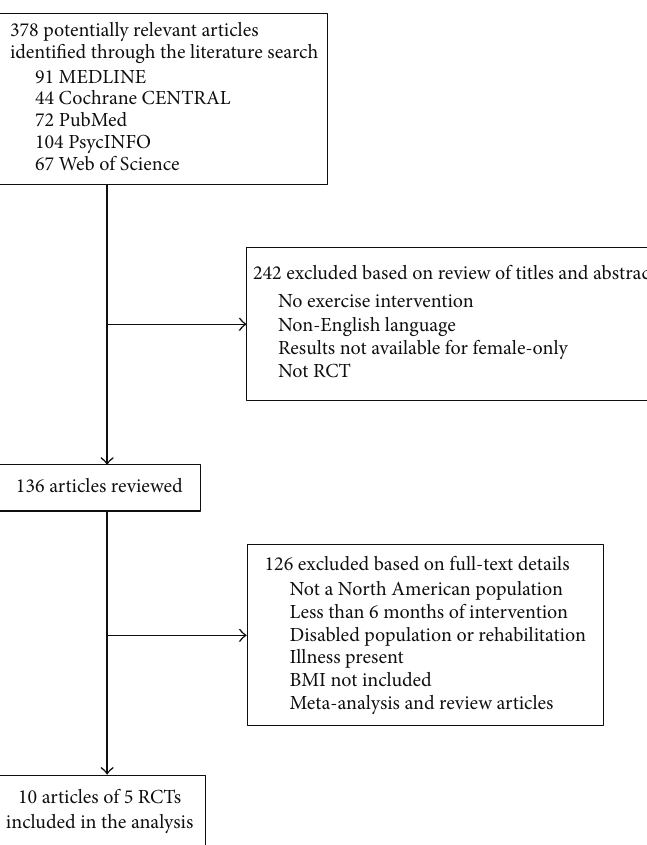
Figure 1: The progressive flow of the study exclusion